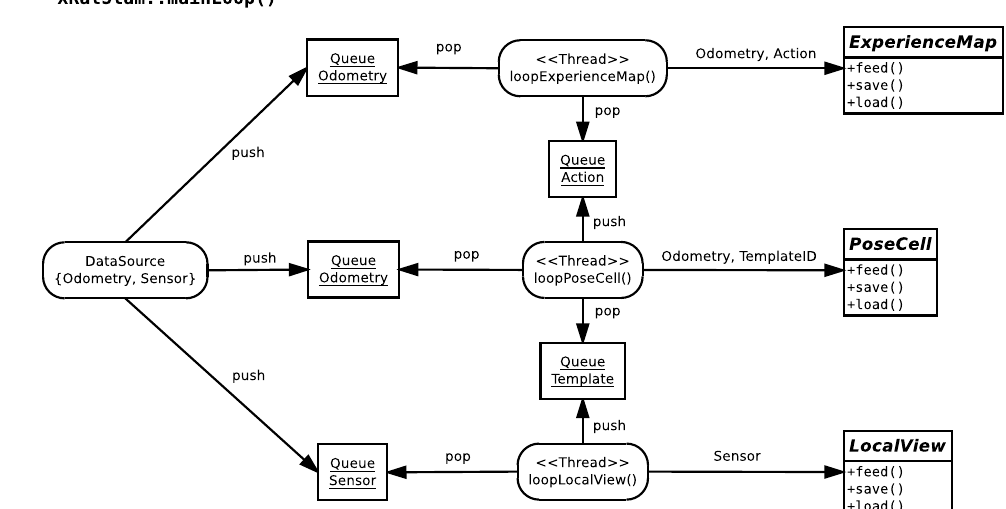
Figure 3. The xRatSLAM main execution loop. The main loop and internal threads communicate using data queues. Incoming odometry and sensor data are stored in its respective queue (Odometry is replicated). Each module (LocalView, PoseCell, and ExperienceMap) has its own thread responsible for reading incoming queue data and communicating with its respective module abstract class to process the data and then store the result in a queue for further processing. Arrows indicate dependencies between